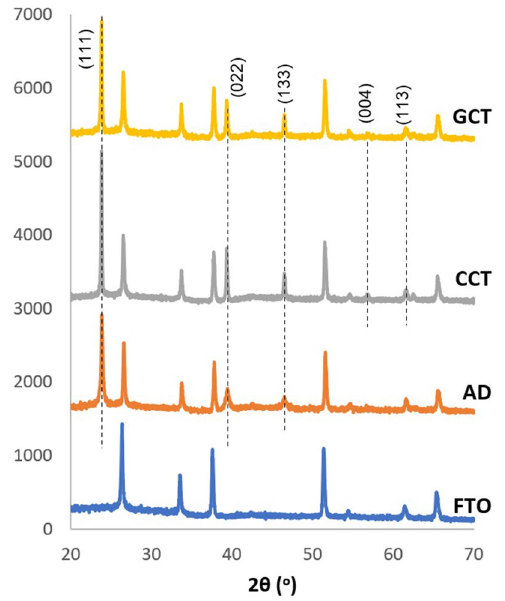
Figure 4. XRD spectra of as-deposited (AD), CdCl 2 -heat treated (CCT) and GaCl 3 heat-treated (GCT) CdMnTe layers grown at a cathodic potential of 1430 mV.